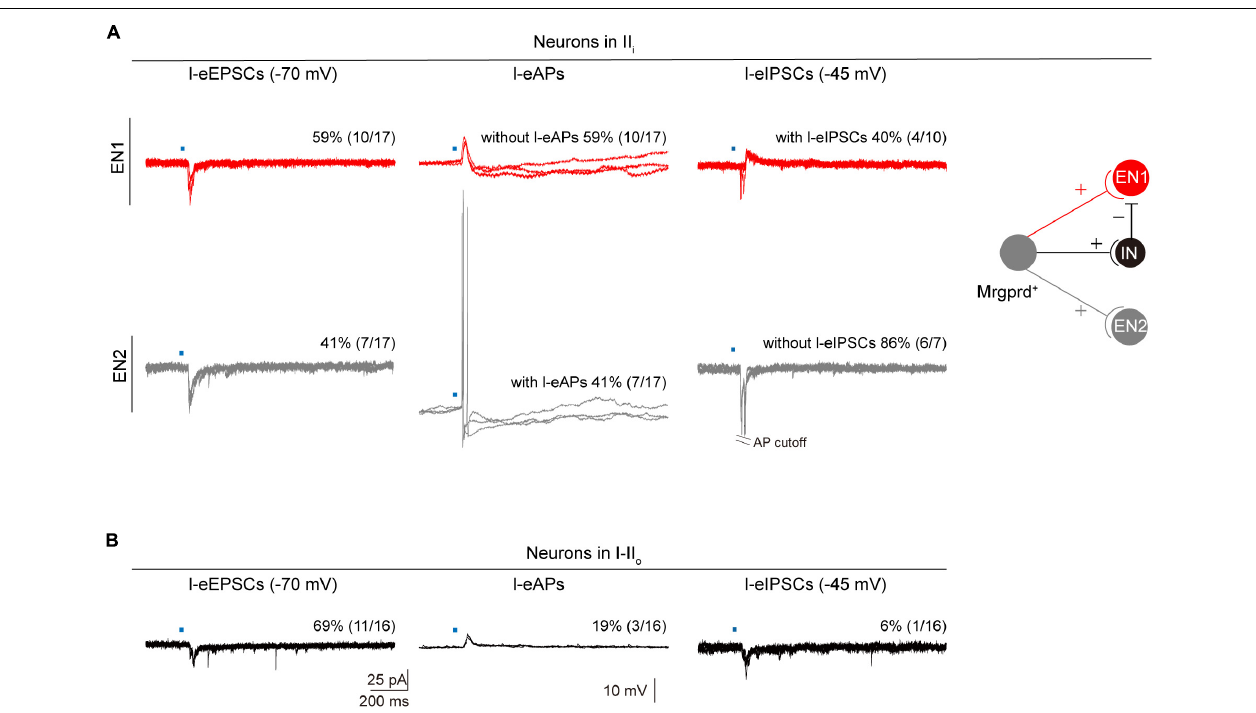
FIGURE 7 | Synaptic inputs and outputs of dorsal horn neurons from Mrgprd + nociceptors. (A) Left: Representative traces and percentage of neurons in lamina II i with l-eEPSCs, l-eAPs and l-eIPSCs. Right: Schematic diagram for synaptic inputs and outputs of EN1 (red) and EN2 (gray) from Mrgprd + nociceptors in naïve Mrgprd-ChR2 mice. (B) Representative traces and percentage of neurons in lamina I–II o with l-eEPSCs, l-eAPs, and l-eIPSCs in naïve Mrgprd-ChR2 mice. (IN: inhibitory neurons, EN1: excitatory neurons that are gated by IN and receive excitatory inputs from Mrgprd + nociceptors, EN2: excitatory neurons that are excited by Mrgprd +